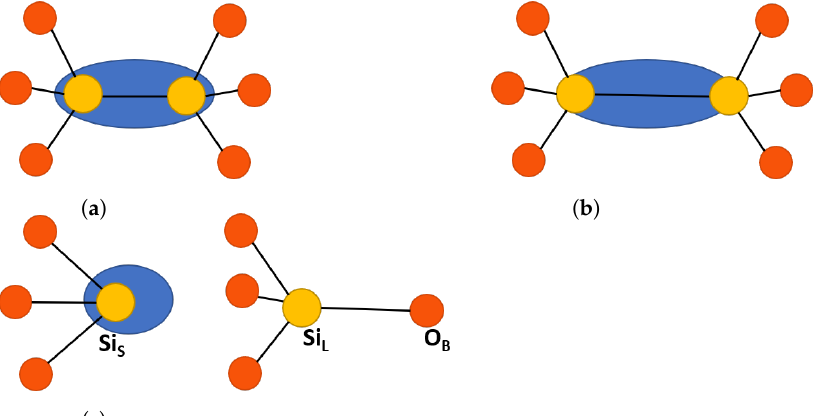
Figure 2. Schematic representation of oxygen vacancy defects in SiO 2 [8]. Yellow atoms are silicon and red atoms are oxygen, the blue oval represents electron localization. ( a ) Neutral dimer configuration, such as ODC(I). ( b ) Positive dimer configuration, such as E (cid:48) E (cid:48) center, showing the back bond between Si L and the back oxygen in the surrounding ring, O B . The 1 labeling is consistent with α -quartz and is described in the